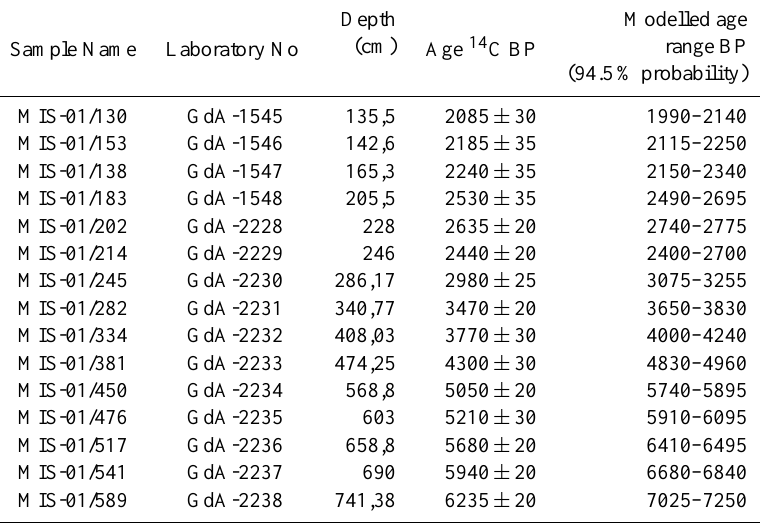
Table 2. Results of 14 C dating for the MIS-08-01b peat core. Independently calibrated age ranges were obtained with the OxCal4 program (Bronk, 2009), and the modelled ages were obtained after “Bacon” calculations (Blaauw and Christen, 2011). In both cases the IntCal09 calibration curve was used (Reimer et al.,